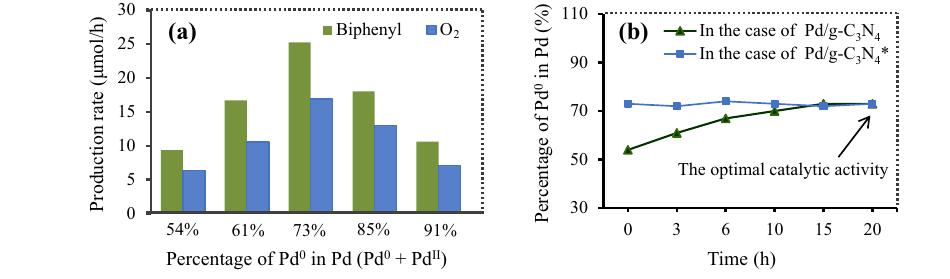
Fig. 8 | Relationship between the Pd 0 concentration and the coupling. a Effect of the percentage of Pd 0 on the average rate of the biphenyl (green) and O 2 (blue) production in 2h. b Time course of the Pd 0 concentration in the case ofPd/g-C 3 N 4